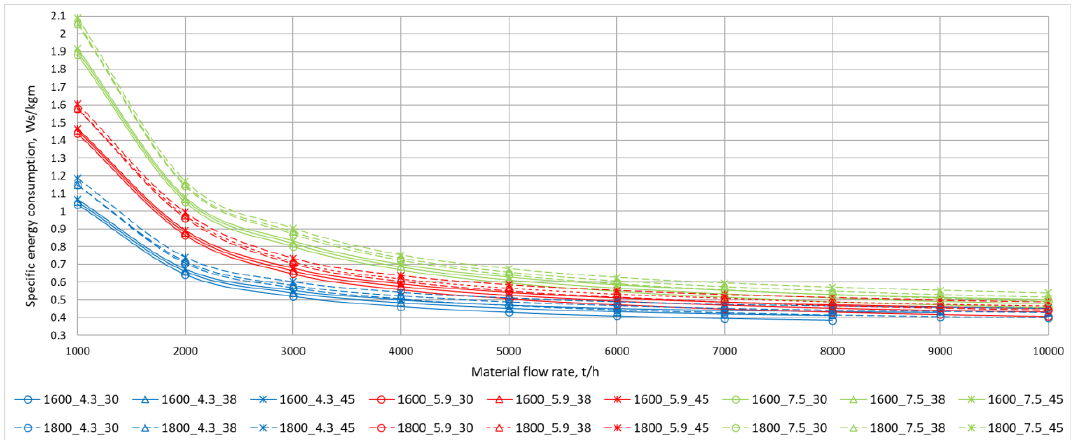
Figure 3. Relationship between specific energy consumption of the conveyor and material flow rate for different conveyor design parameters. (Code in the legend represents the belt width, speed, and troughing angle).